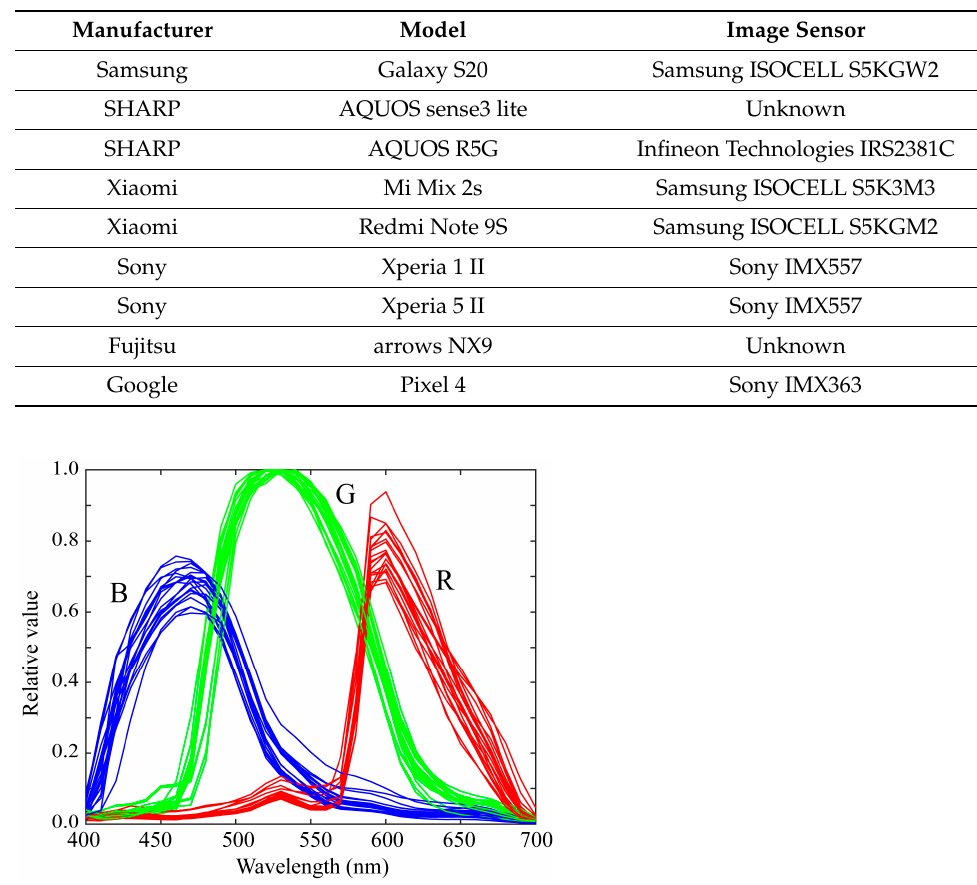
Figure 3. Relative spectral sensitivity functions of the 20 mobile phone cameras in our database.